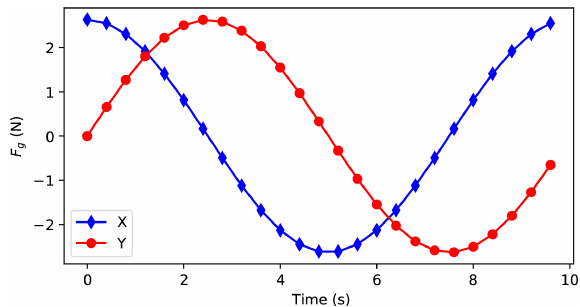
Figure 15. Gravity compensation force F g .